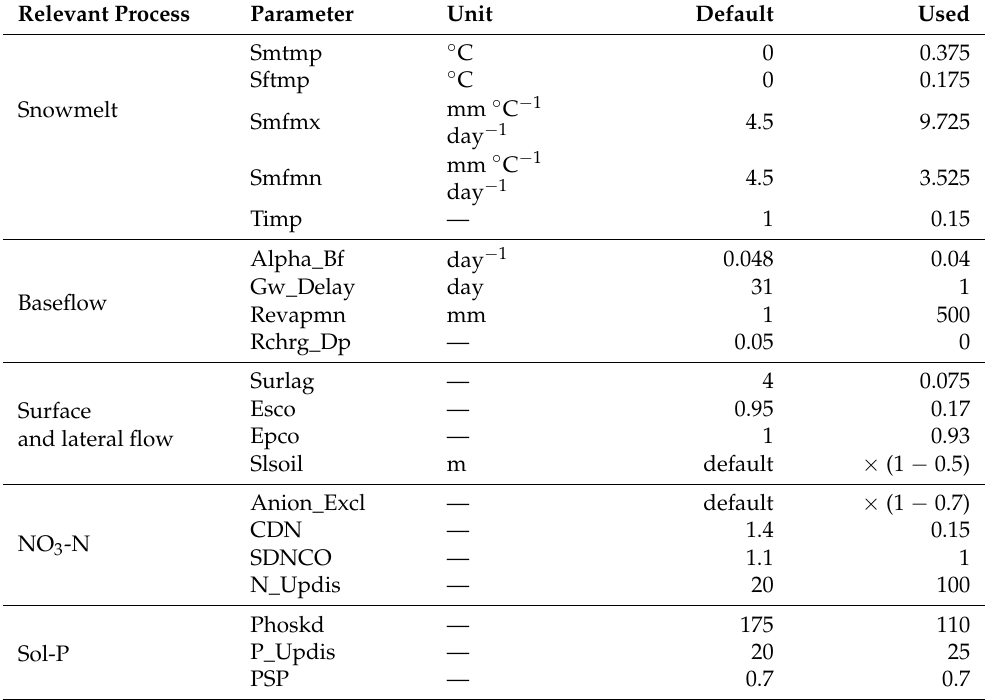
Table 4. Parameters adjusted during calibration of